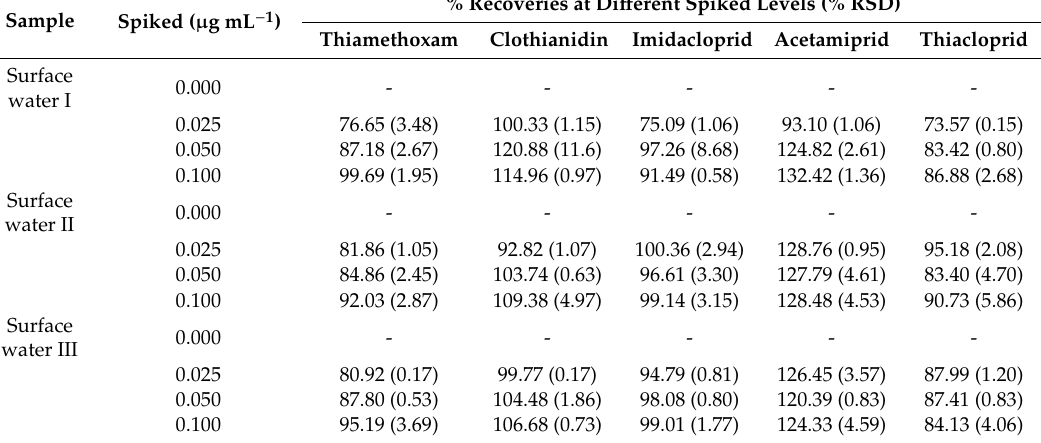
Table 2. Recovery obtained for the determination of neonicotinoid insecticides in natural surface water samples (n =